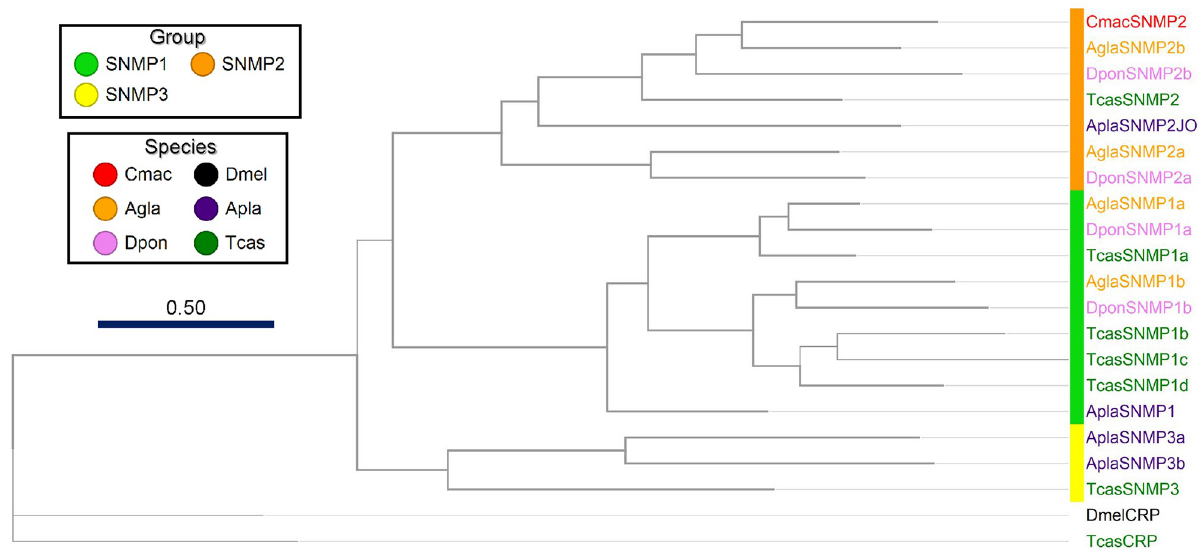
Fig 4. Maximum-likelihood phylogenetic tree of putative Callosobruchus maculatus sensory neuron membrane protein (SNMP) with insect SNMP sequences, Dendroctonus ponderosae (Dpon), Agrilus planipennis (Apla), Anoplophora glabripennis (Agla), Tribolium castaneum (Tcas), and Drosophila melanogaster (Dmel). The tree was rooted with the croquemort (Crq) protein lineage, a member of the CD36 family that is non- SNMP. Thick nodes are supported by a bootstrap value > 60%. The rate of amino-acid substitutions per site is shown in the scale bar.